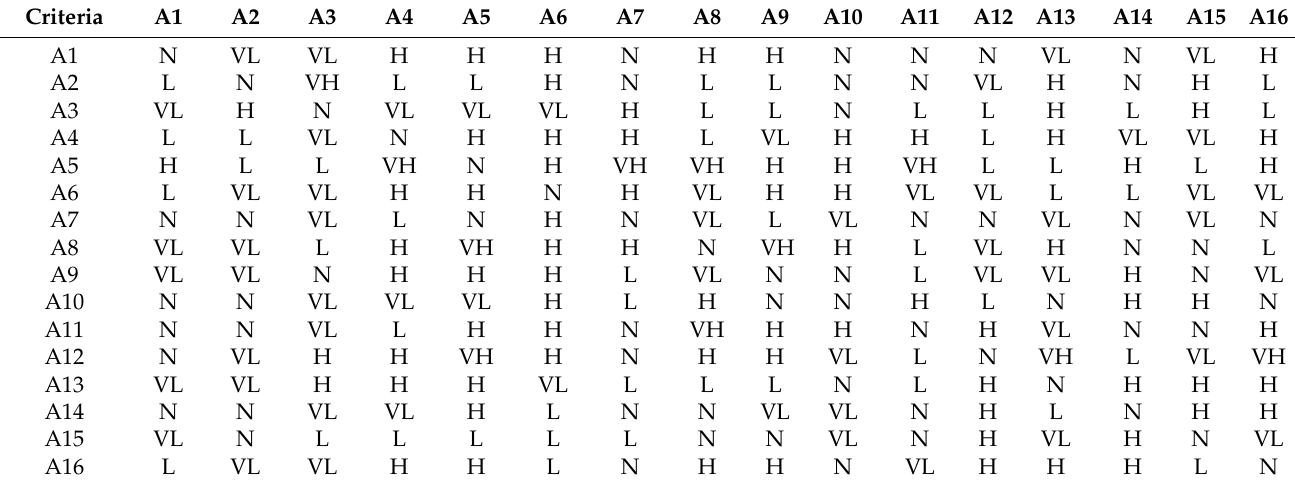
Table 3. The fuzzy direct matrix T—the TBL’s perspective.